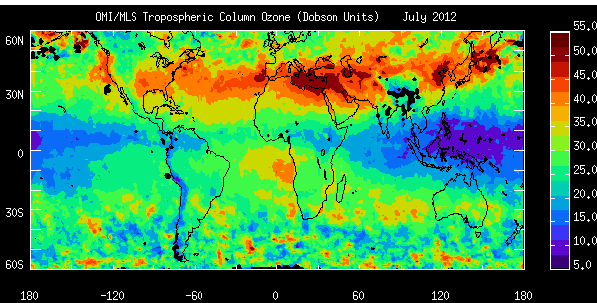
Figure 24. Tropospheric ozone columns determined by residual from OMI observations of total column O 3 and MLS observations of stratospheric O 3 (Ziemke et al., 2006). Plots retrieved from http: //acd-ext.gsfc.nasa.gov/Data_services/cloud_slice/index.html#nd.